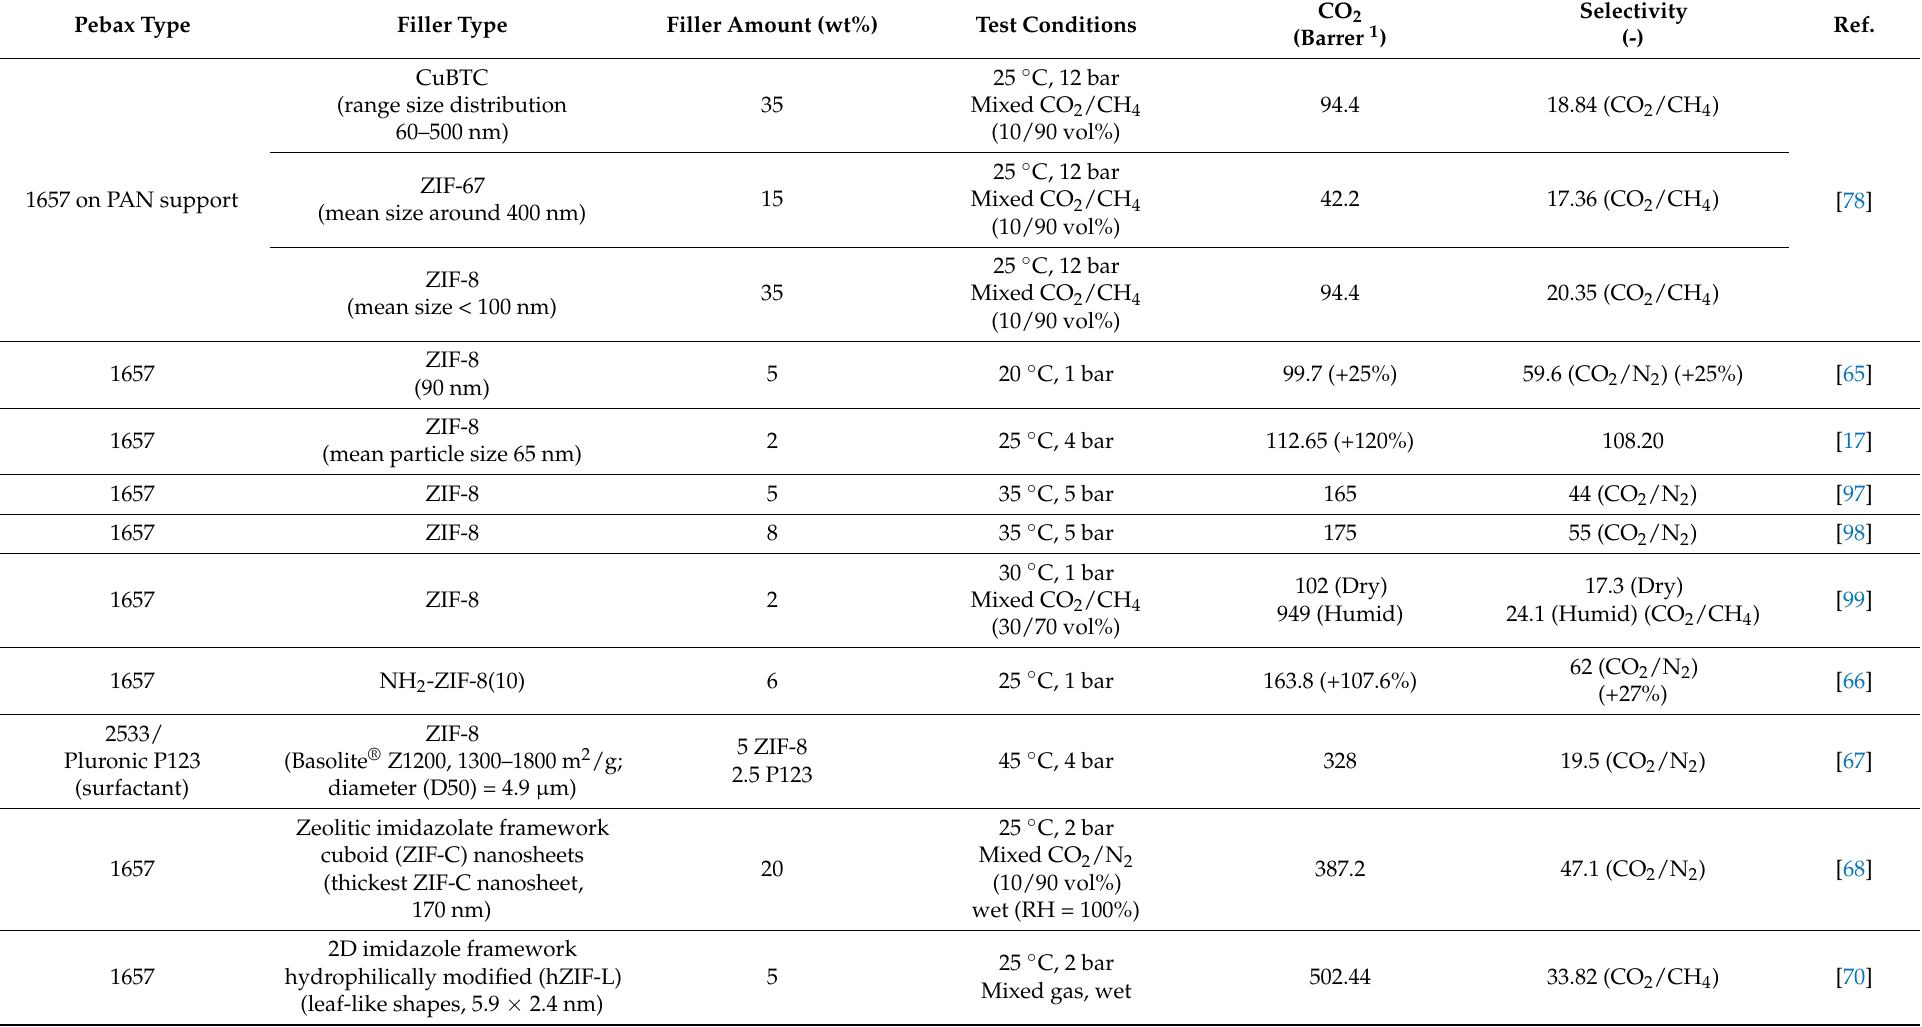
Table 7. Permeation properties of selected Pebax-based MMMs filled with